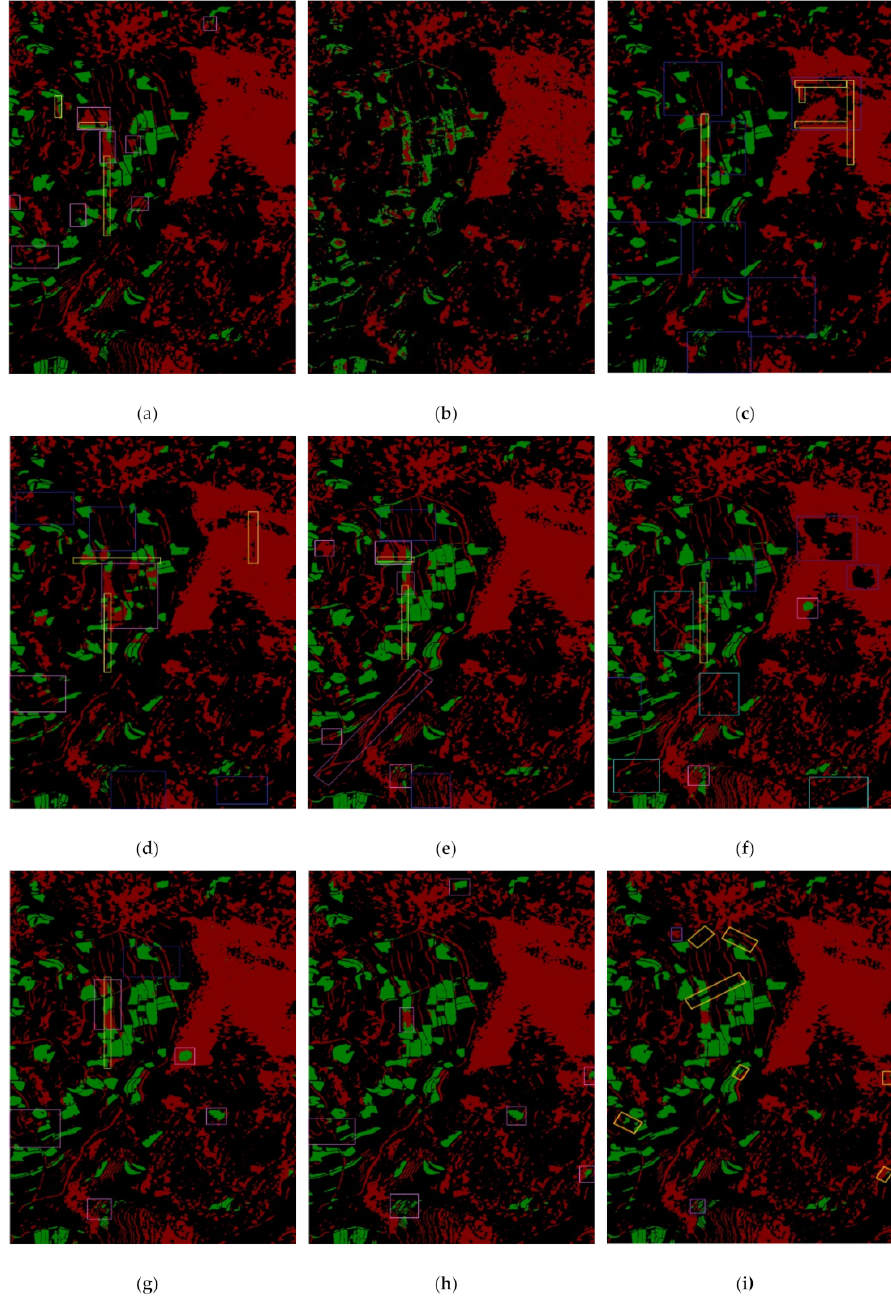
Table 4. For simplicity, we use EN_M1 , L_En_M1 , R-101_FCN, G_En_M1 , G_En_M1_2 , and L_K_M to represent Encoder_MFEF1 , Lee_Encoder_MFEF1 , ResNet-101_FCN, GLGCM_Encoder_MFEF1